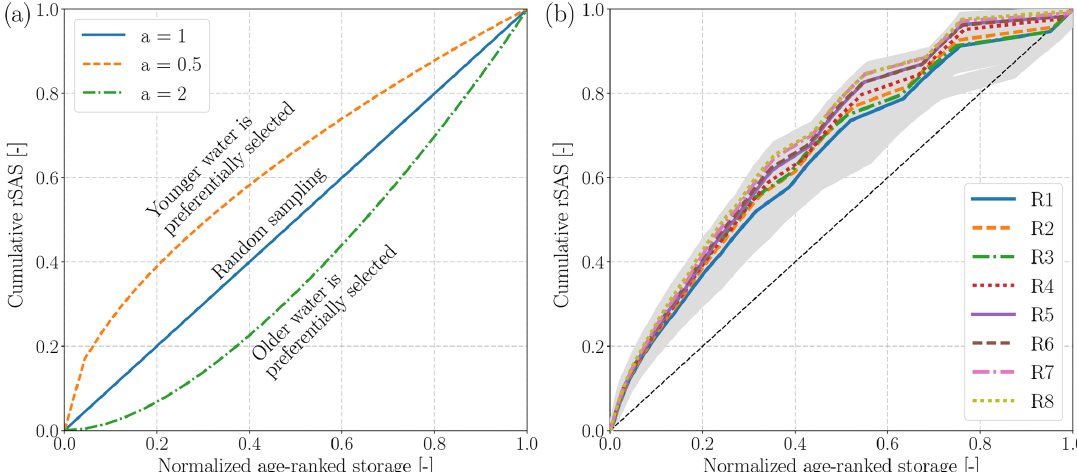
Figure 9. Cumulative rank SAS functions as a function of normalized age-ranked storage. (a) Schematic of cumulative rank SAS functions parameterized by gamma distribution with the shape parameter a = 0 . 5, 1, and 2. (b) Cumulative rank SAS functions of the ensemble simulations (light grey lines) and the ensemble average for each recharge